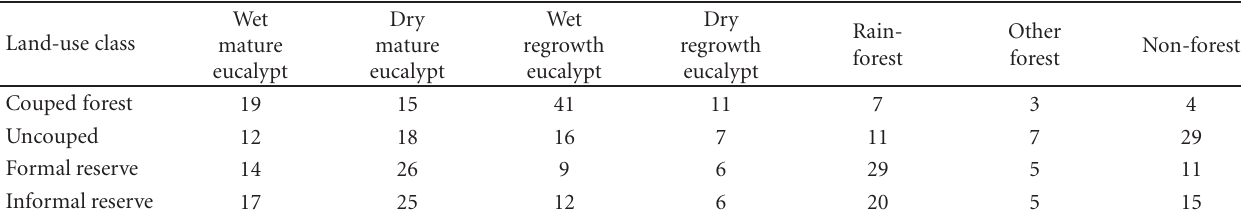
Table 3: Areas of forest cover types for each land-use category on Tasmanian State forest. All figures are % area. Wet Land-use class